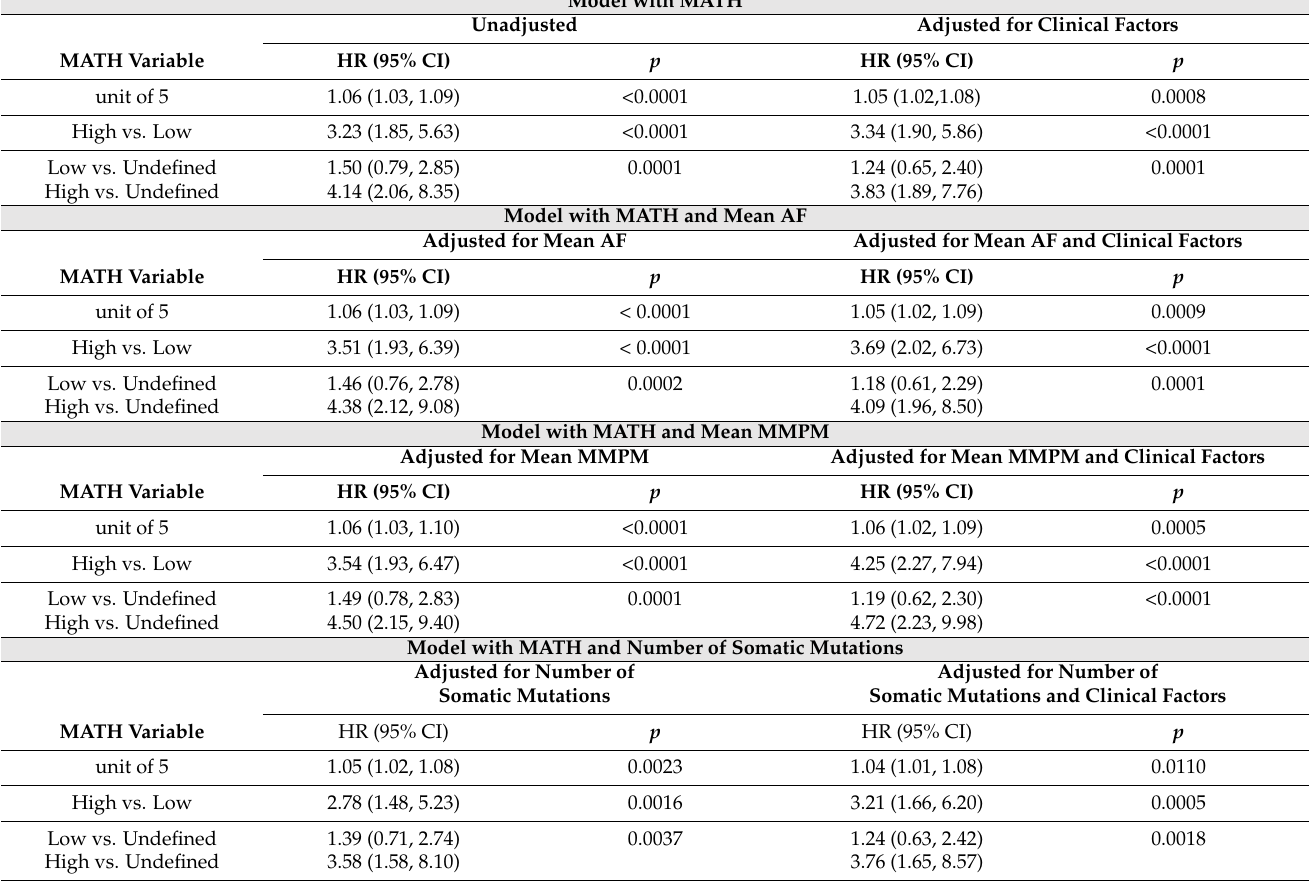
Table 4. Association of post-induction MATH with PFS. Global p -values presented for MATH categories with more than two levels (low vs. high. vs. undefined). Clinical factors for adjustment were treatment arm and liver resection during first